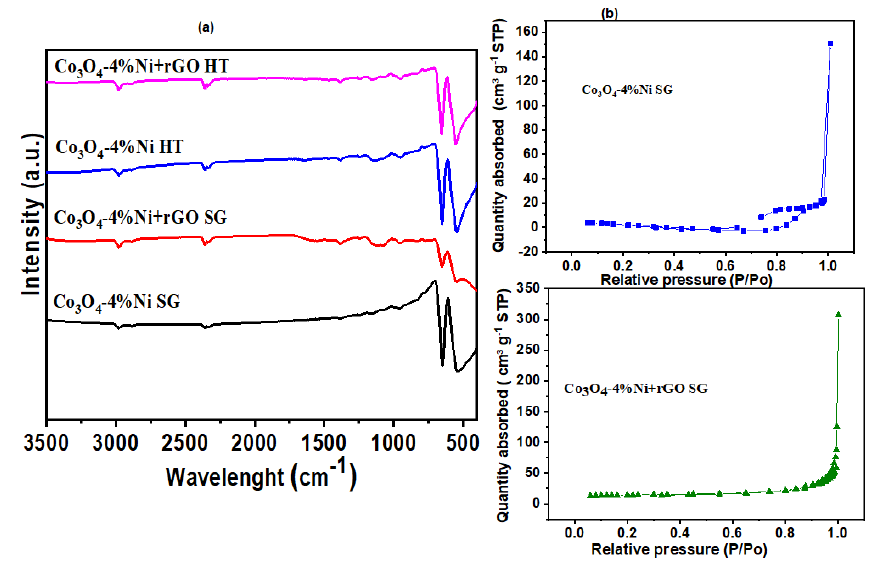
Figure 5. ( a ) FTIR Spectrum Co 3 O 4 nanoparticles. ( b ) BET Surface Area